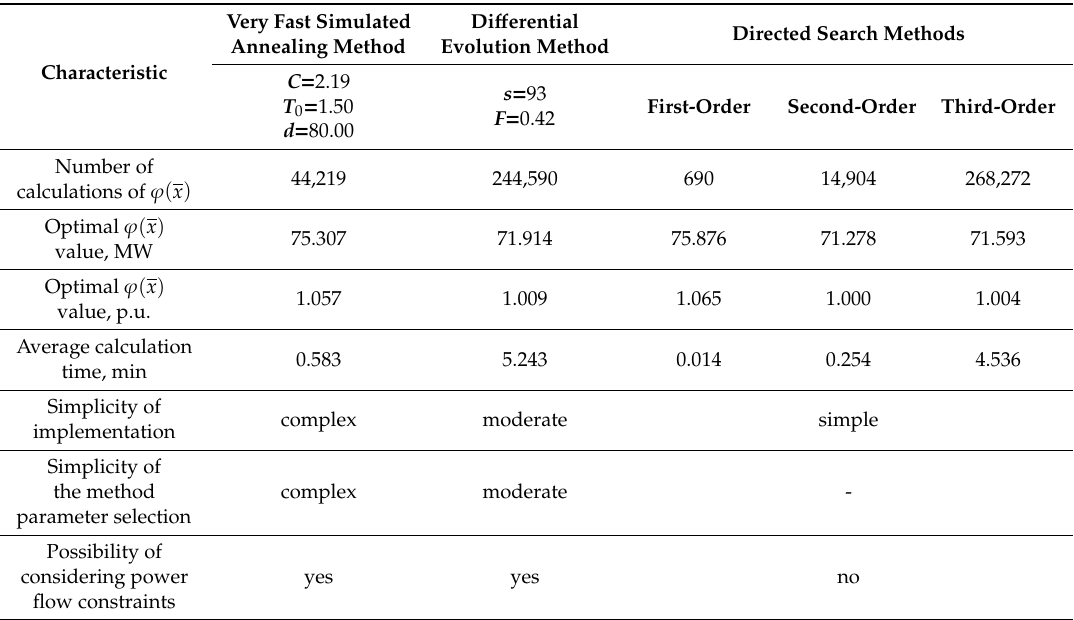
Table 5. Maintenance scheduling results for the first test system.